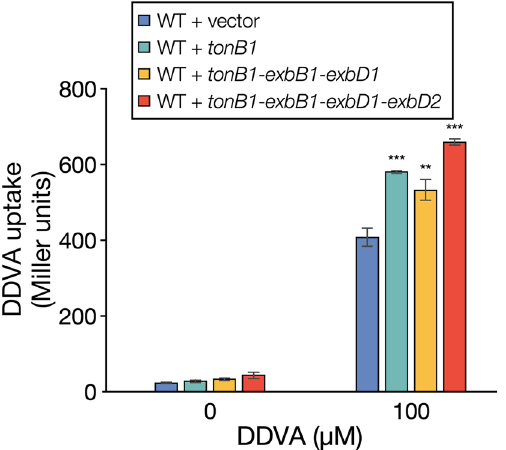
Figure 4. DDVA uptake by SYK-6 cells overexpressing the tonB1 operon genes. The uptake of DDVA by SYK-6 cells overexpressing the tonB1 operon genes was evaluated using the DDVA sensor plasmid pS-XR, which was constructed by applying the regulatory system of the DDVA catabolic genes 24 . The β-galactosidase activities of cells of SYK-6(pS-XR + pSEVA338 [vector]), SYK-6(pS-XR + pS-tonB1), SYK-6(pS-XR + pS-t1-D1), and SYK- 6(pS-XR + pS-t1-D12) incubated in Wx-SEMP with or without 100 µM DDVA were measured. Each value is the average ± the standard deviation of three independent experiments. Asterisks show statistically significant differences between cells overexpressing the tonB1 operon genes and vector control cells incubated in the